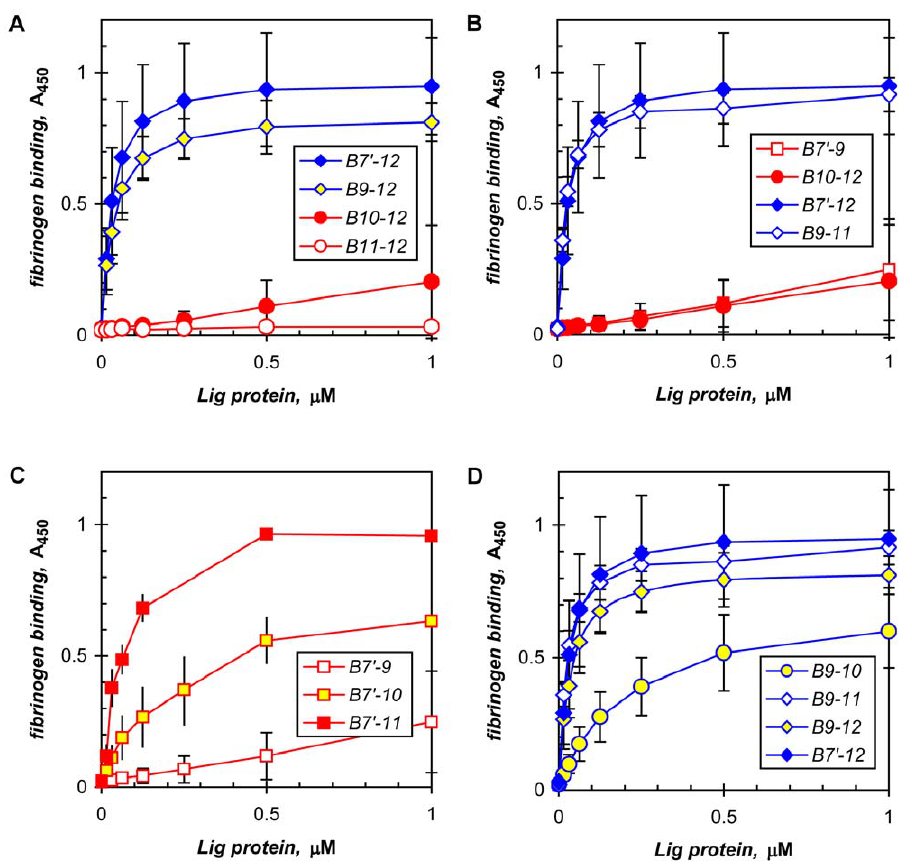
Figure 5. LigB repeats in fibrinogen binding. Recombinant LigB proteins comprising the indicated immunoglobulin-like repeats were tested in an ELISA to identify the fibrinogen-binding region. Composite binding curves with means and standard deviations (standard errors for LigB9-11, and ranges for LigB7 9 -10 and LigB7 9 -11) from multiple experiments show that A ) repeat 9 is necessary and the carboxy-proximal repeats, especially 11 and 12, do not bind by themselves, B ) a repeats 9-10 nexus is necessary and B9-11 is sufficient for full activity, C ) low- (10) and non-binding (11) repeats enhance activity, and D ) non-binding repeat 11 is needed for complete fibrinogen binding. See text and Table 2 for comparative K d s. ( Table 2 ). With little variation, the same LigB proteins exhibit full activity with similar avidity for both host proteins ( Table 2 ). In the moderate-affinity group, the LigB proteins contain the repeats 9/ 10 interface, but lack repeat 11, with the exception of LigB7 9 -11 in fibrinogen binding being at the high end of this category. The promotion of the proteins in the moderate-binding group to full activity entails three- to eightfold enhancement by repeat 11 for fibronectin binding and three- to sixfold stimulation in fibrinogen binding ( Table 2 ). Although we have not determined the sequences required for collagen binding, LigB9-11 also binds type III collagen ( Figure 2B ).